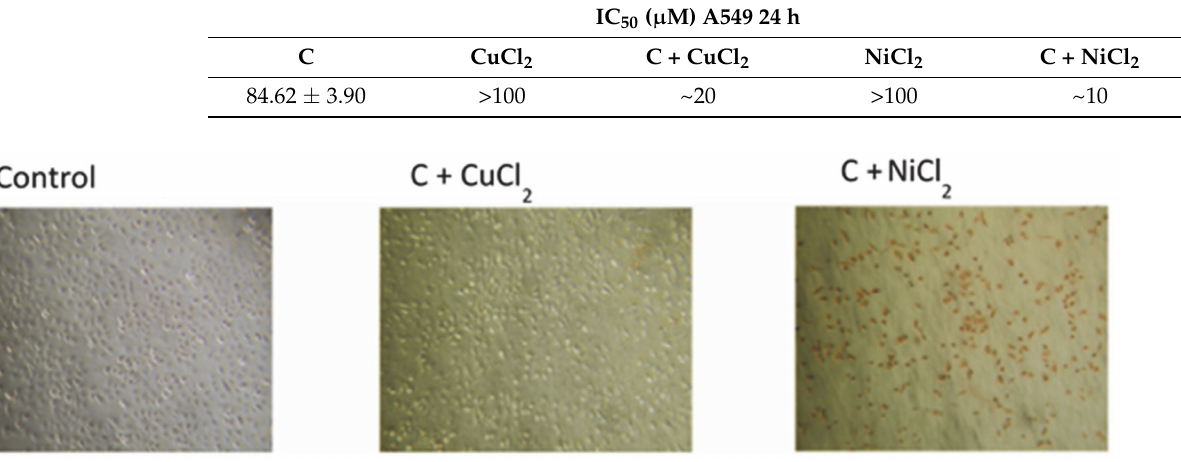
Figure 5. Pictures of A549 cells untreated and treated with C mixed with copper(II) and nickel(II)